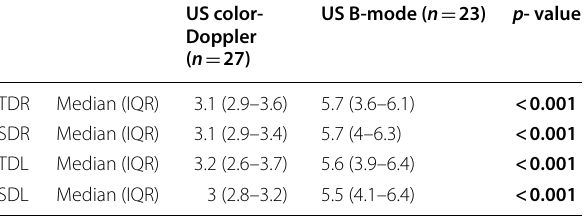
Table 3 Median and IQR of color-Doppler and B-mode US ONSD assessment: for all four diameters the comparison between median values differs significantly ( p -value <